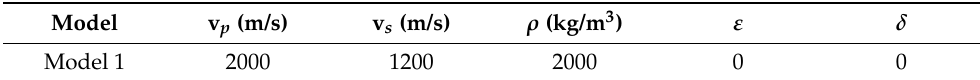
Table 1. Parameters of model